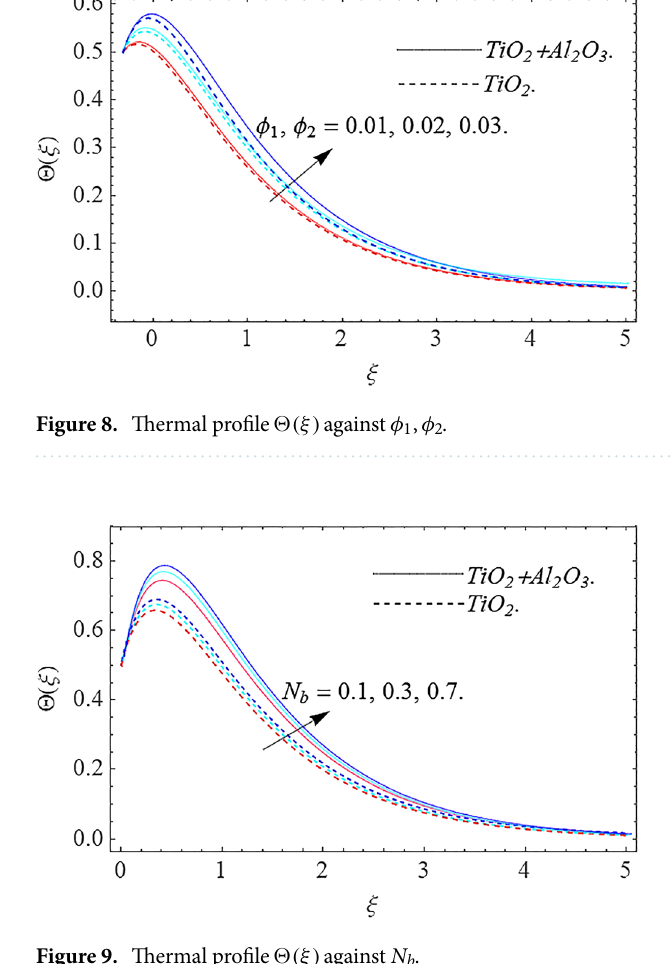
Figure 9. Thermal profile �(ξ) against N b .